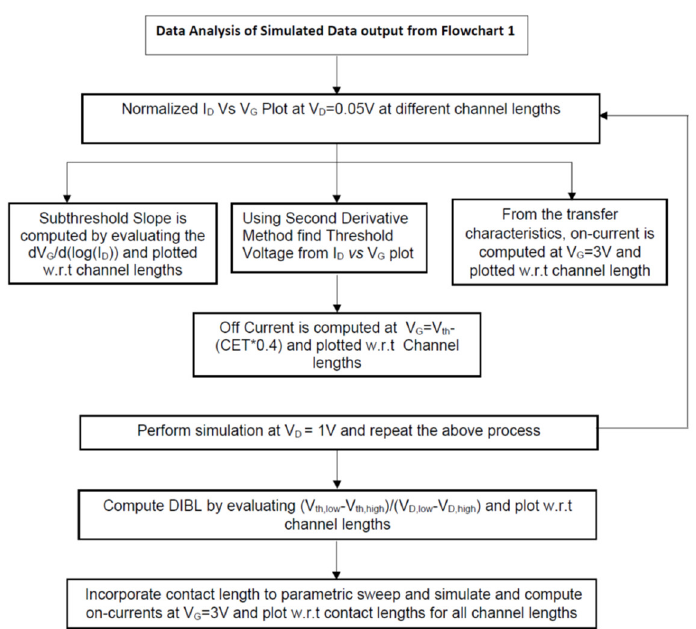
Figure 3. A flowchart depicting the steps followed to arrive at the derived plots using COMSOL. The transfer characteristics (VTC) for various channel lengths at a low drain voltage of 0.05 V (to avoid drain-induced effects) are presented in Figure 4.